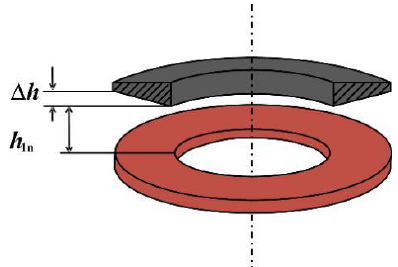
Figure 2. Tapered film.